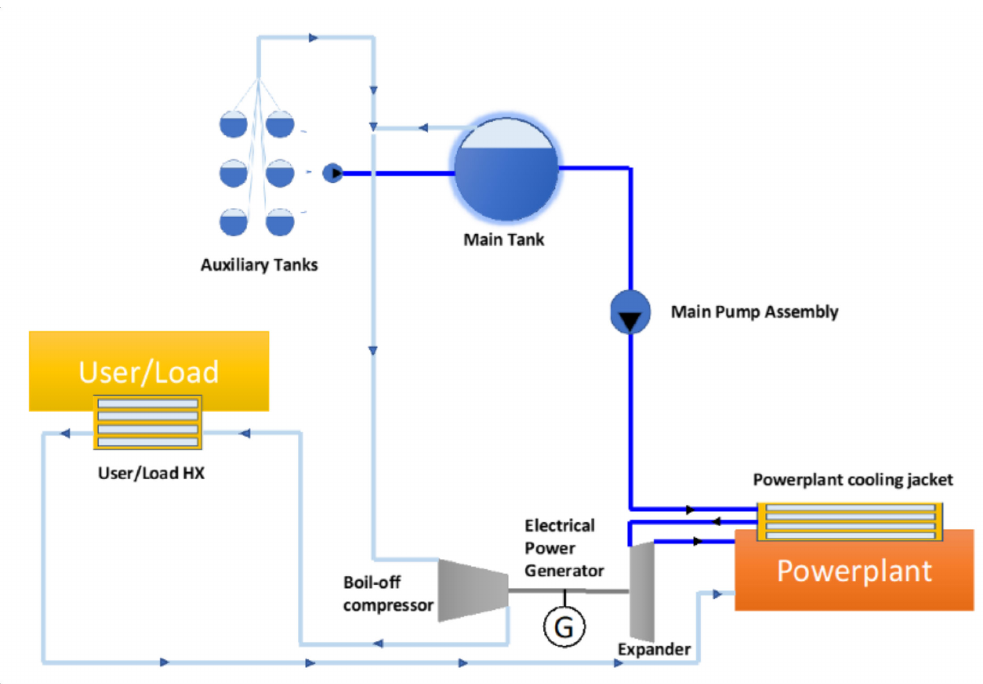
Figure 3. Thermal and energy management system on board the STRATOFLY